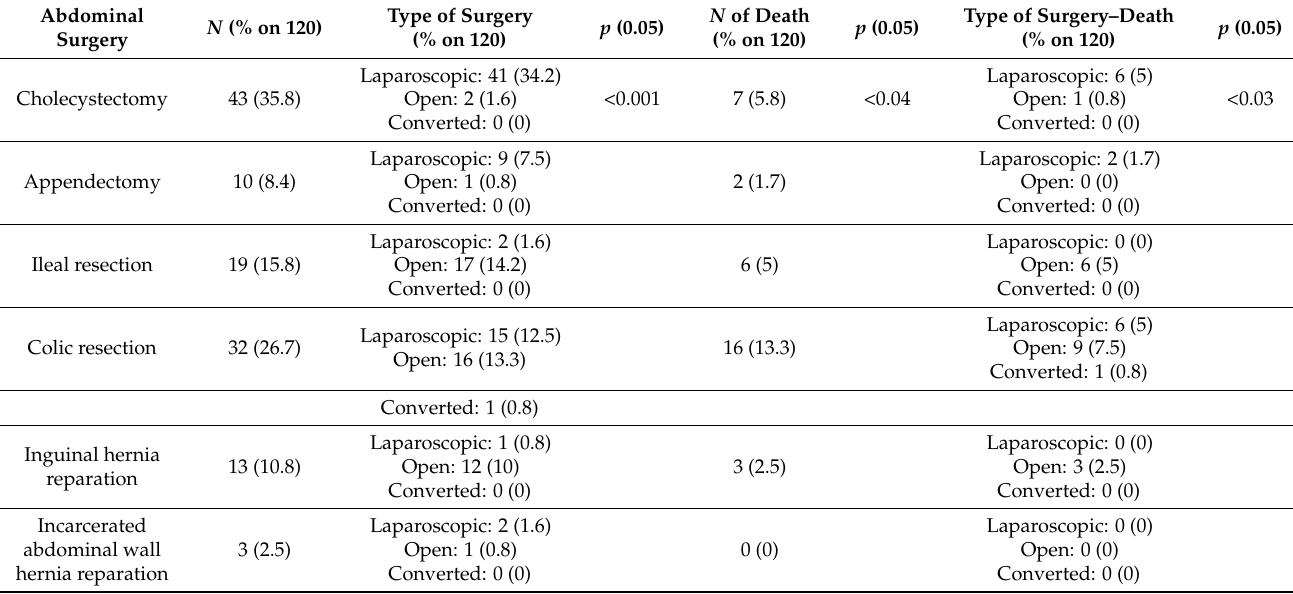
Table 6. Abdominal surgery ( N ) and % on 120, type of surgery (% on 120), mortality (% on 120), death in the different types of surgery (% on 120), and p (0.05).